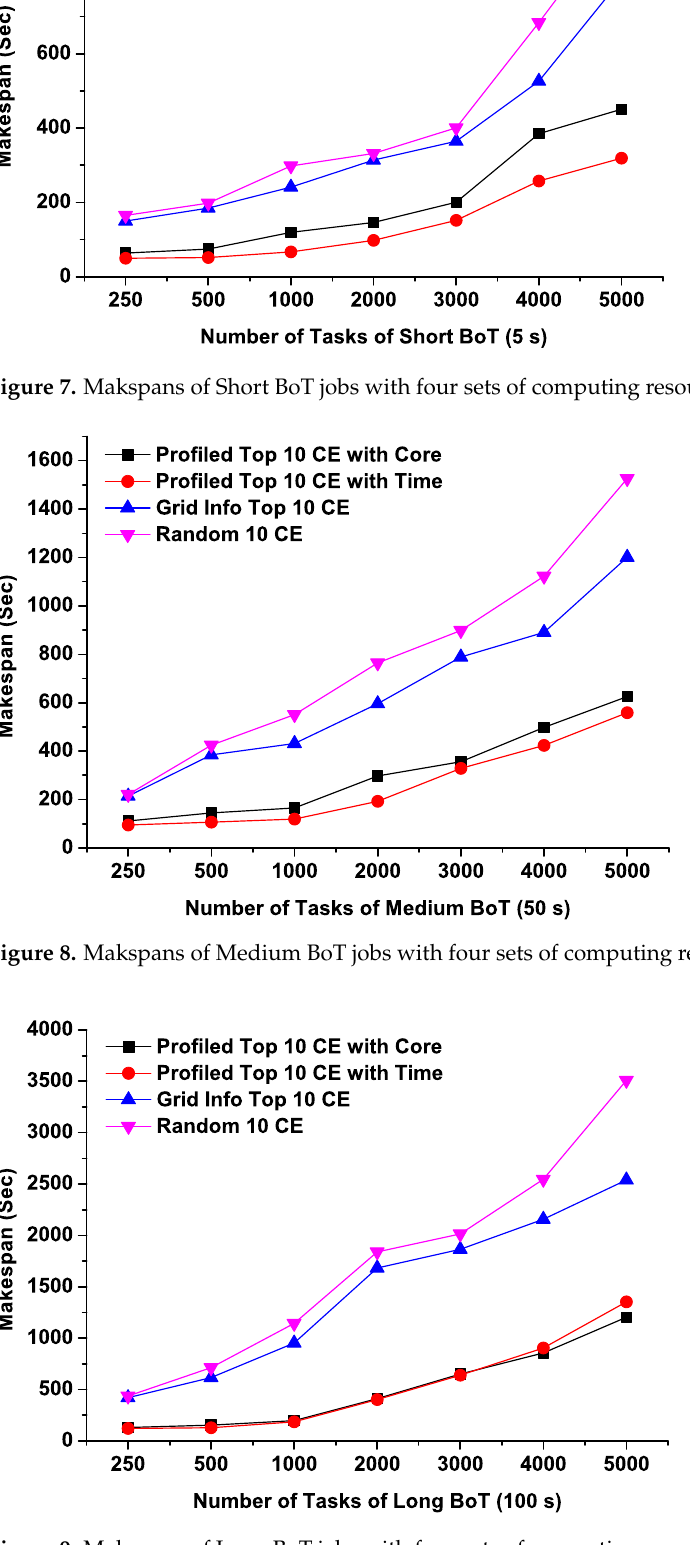
Figure 9. Makspans of Long BoT jobs with four sets of computing